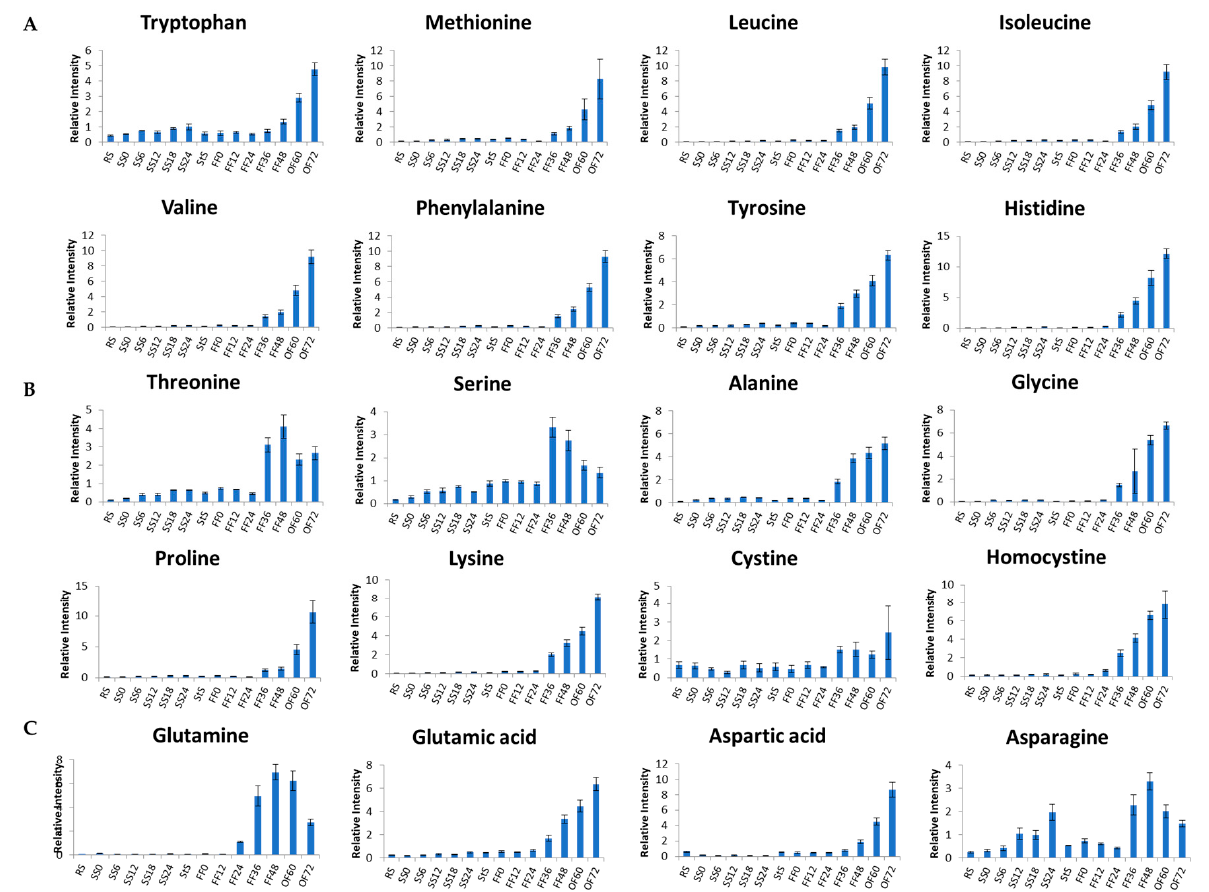
Figure 7. ( A ) Amino acids contributing to a bitter taste. ( B ) Amino acids contributing to a sweet flavor. ( C ) Amino acids contributing to an umami/meaty and/or sour flavor. The vertical axis represents relative intensity. The horizontal axis represents the samples. The error bars show the standard deviation obtained from three replicates.